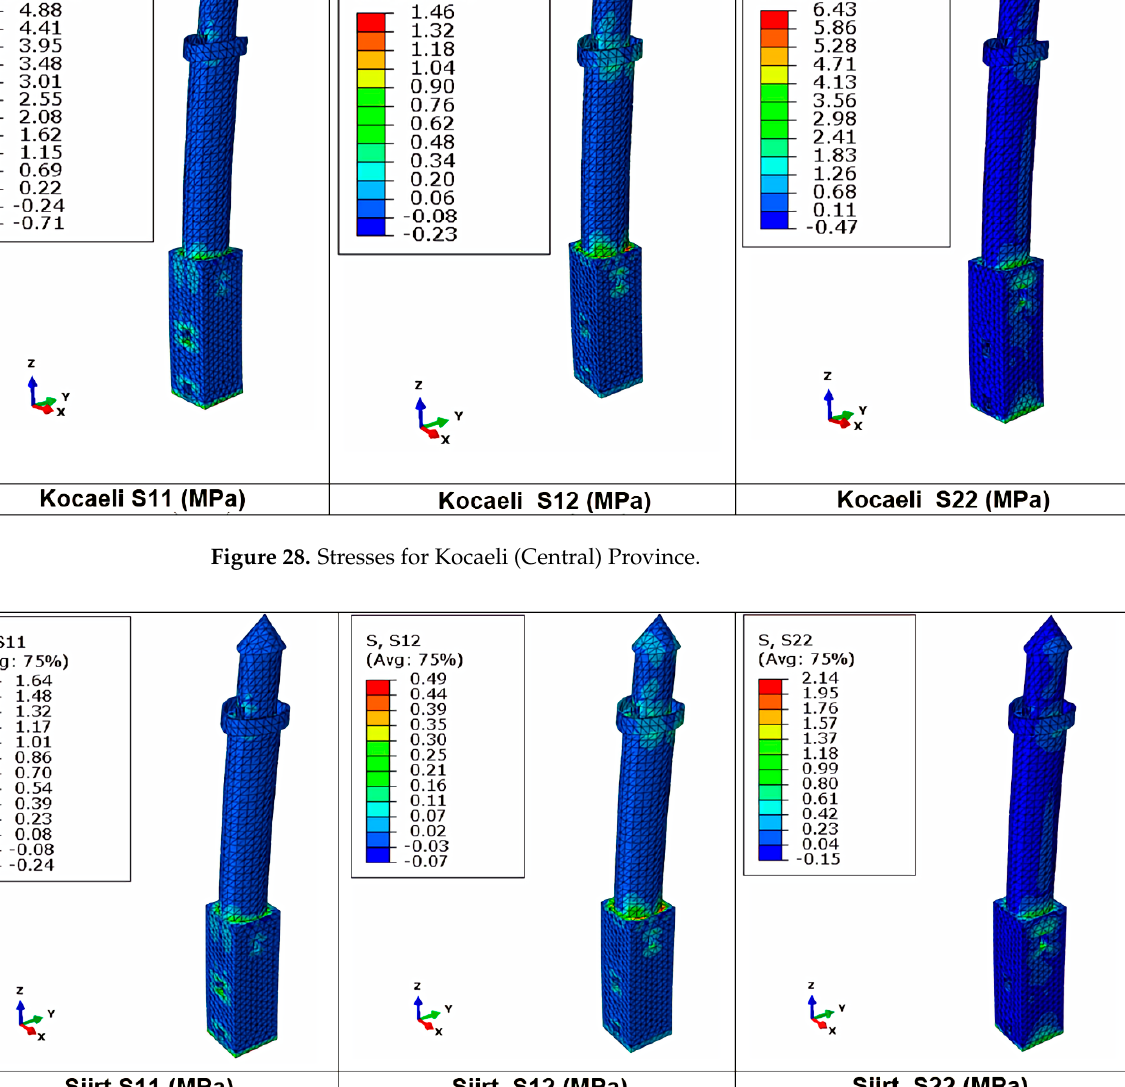
Table 13. Comparison of the results obtained for different settlements. Location